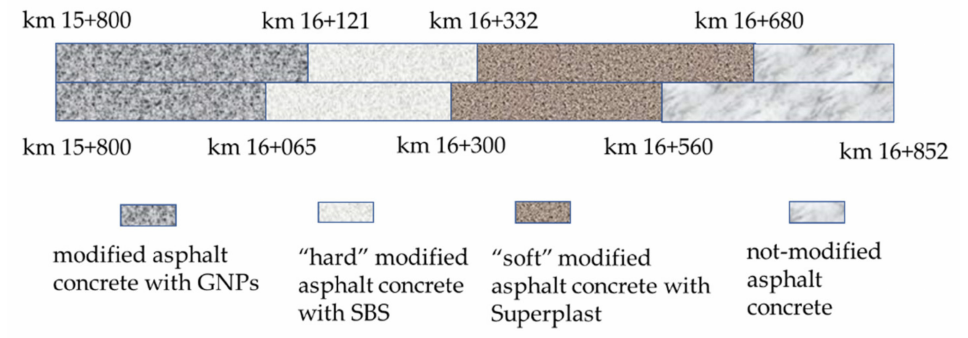
Figure 1. Longitudinal section of the experimental stretch.